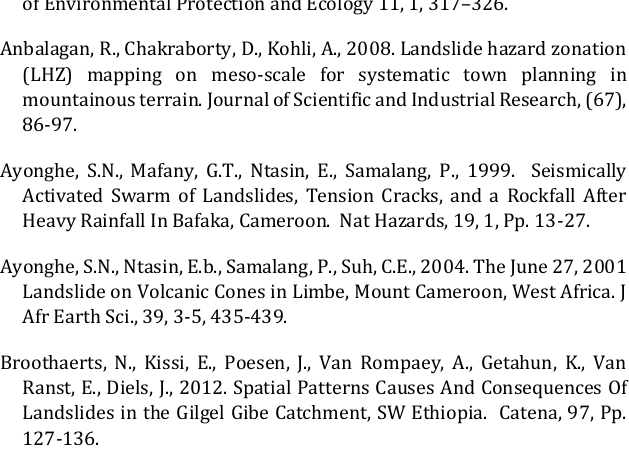
Figure 8: Elevation Map of the Study Area.